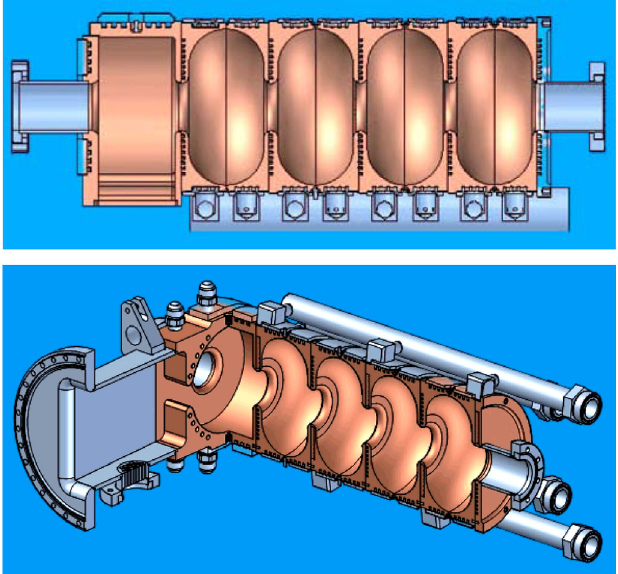
FIG. 1. (Color) Cross sectional view of the five-cell cavity where the coupler cell is on the left and an rf probe (not shown) is located in the beam pipe just outside the rightmost cell. Cooling water circulates through rectangular grooves in the irises and outer cavity